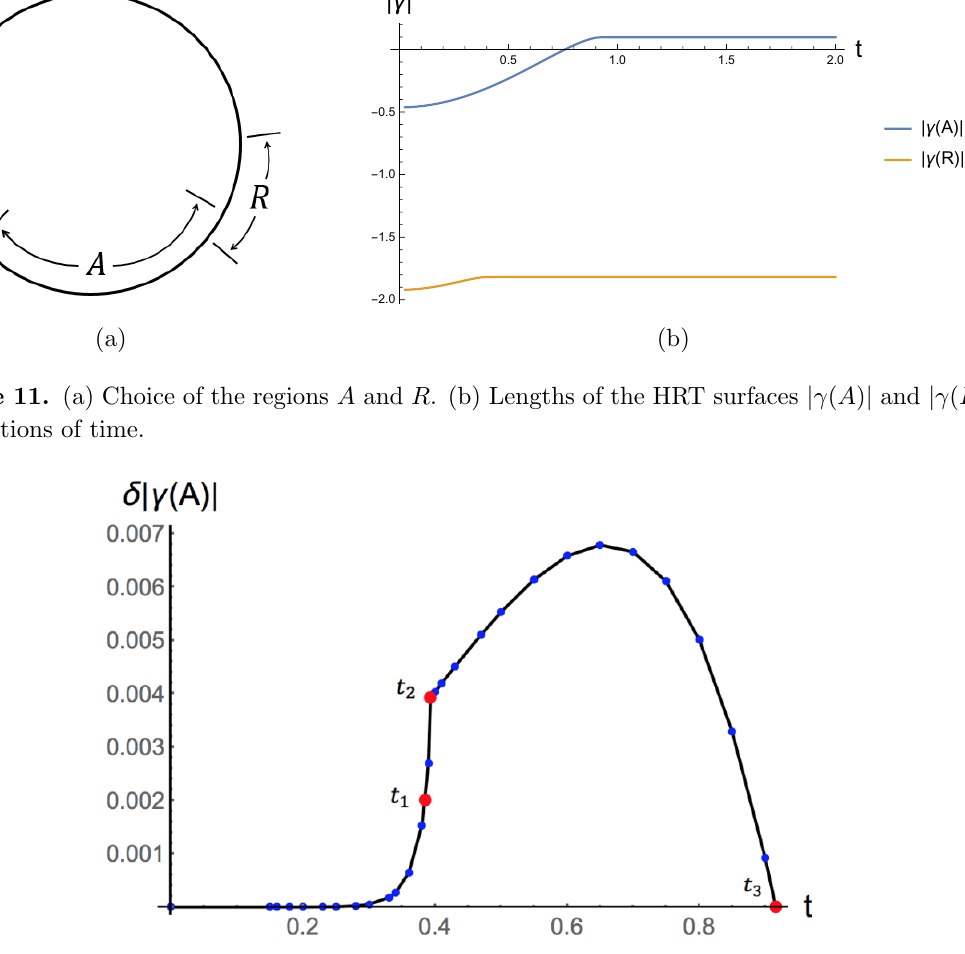
Figure 12. (cid:14) j (cid:13) ( A ) j = j (cid:13) ( A ) j (cid:0) j (cid:13) R ( A ) j as a function of